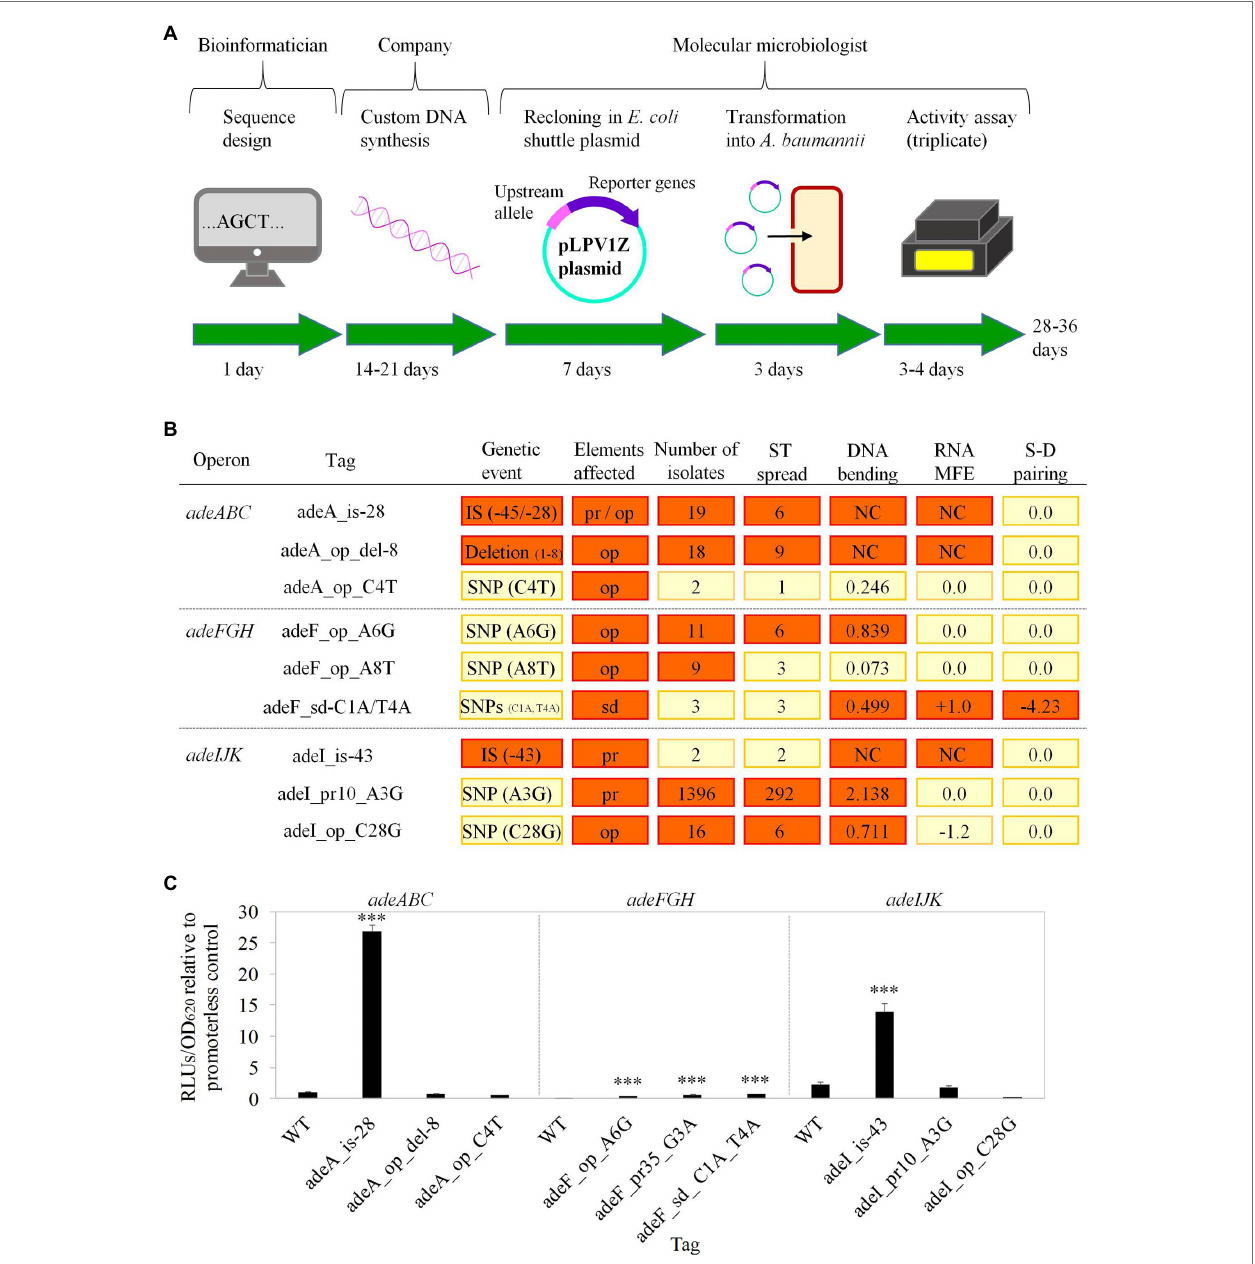
FIGURE 2 | Experimental validation of selected tags. (A) Timeline schema of the experimental validation pipeline. Stages, human staff involved, and their estimated time duration are shown. (B) Tags selected for experimental evaluation. Tag nomenclature include the first gene of the pump operon followed by either the label “-is” plus the insertion distance to start codon (for ISs), or the element affected (op: operator; pr: promoter; and sd: Shine-Dalgarno sequence) plus the “del” label plus the length of the removed section (for deletions) or the nucleotide change (for point mutations). For clarity, values for parameter criteria utilized for tag prioritization are highlighted in red when deemed relevant: deletions or IS (genetic event); opt, pr, and sd (elements affected); ≥ 5 isolates carrying the tag (number of isolates); ≥ 5 different STs with isolates carrying the tag (ST spread); ≥ 0.5 degrees per turn difference respect to the WT (DNA bending); ≥ 1 Kcal/mol differences in RNA MFE (RNA MFE); and ≥ 1 Kcal/mol differences in Shine-Dalgarno (S-D) and anti-S-D ribosomal sequence pairing (S-D pairing). IS alleles were clustered if the insertion point was so proximal that the same motifs were affected. The number of isolates that harbor the tag is shown together with the number of alleles involved under brackets. Isolates not included in formal STs were considered together as a single unit for the ST count estimation. DNA bending, RNA MFE, and S-D pairing columns indicate maximal differences of the tag-carrying sequence respect to the WT in degrees per turn for the former, and Kcal/mol for the rest parameters. NC, non-comparable. (C) Expression activity of prioritized alleles measured by luminometry. Fold-changes of normalized RLUs associated to the alleles respect to the promoterless cells are shown. Cells containing plasmids with WT upstream sequences for adeABC , adeFGH , and adeIJK pumps showed 103 ± 9%, 5 ± 2%, and 220 ± 46% expression values, with respect to the original promoterless plasmid, respectively. Data are the averages ± SDs of four independent experiments. Statistical significance was calculated using the two-tailed Student’s t -test. Significant differences are indicated: *** p <